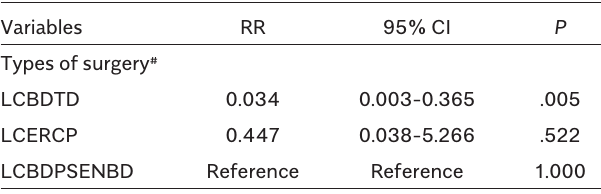
Table 2. Relative Risk for Bile Leakage